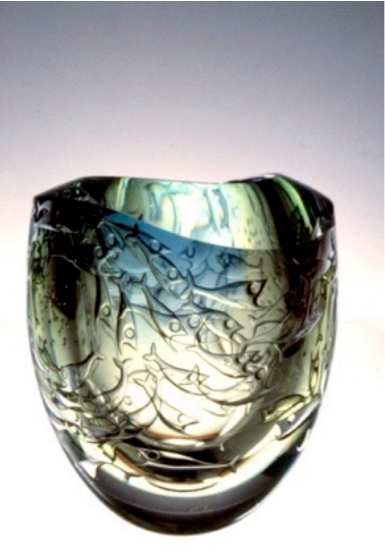
Figure 16. Ray Flavell, “Double Fish” blown glass with ariel technique, cold finished and polished, 2001. Courtesy of the artist, used with permission.